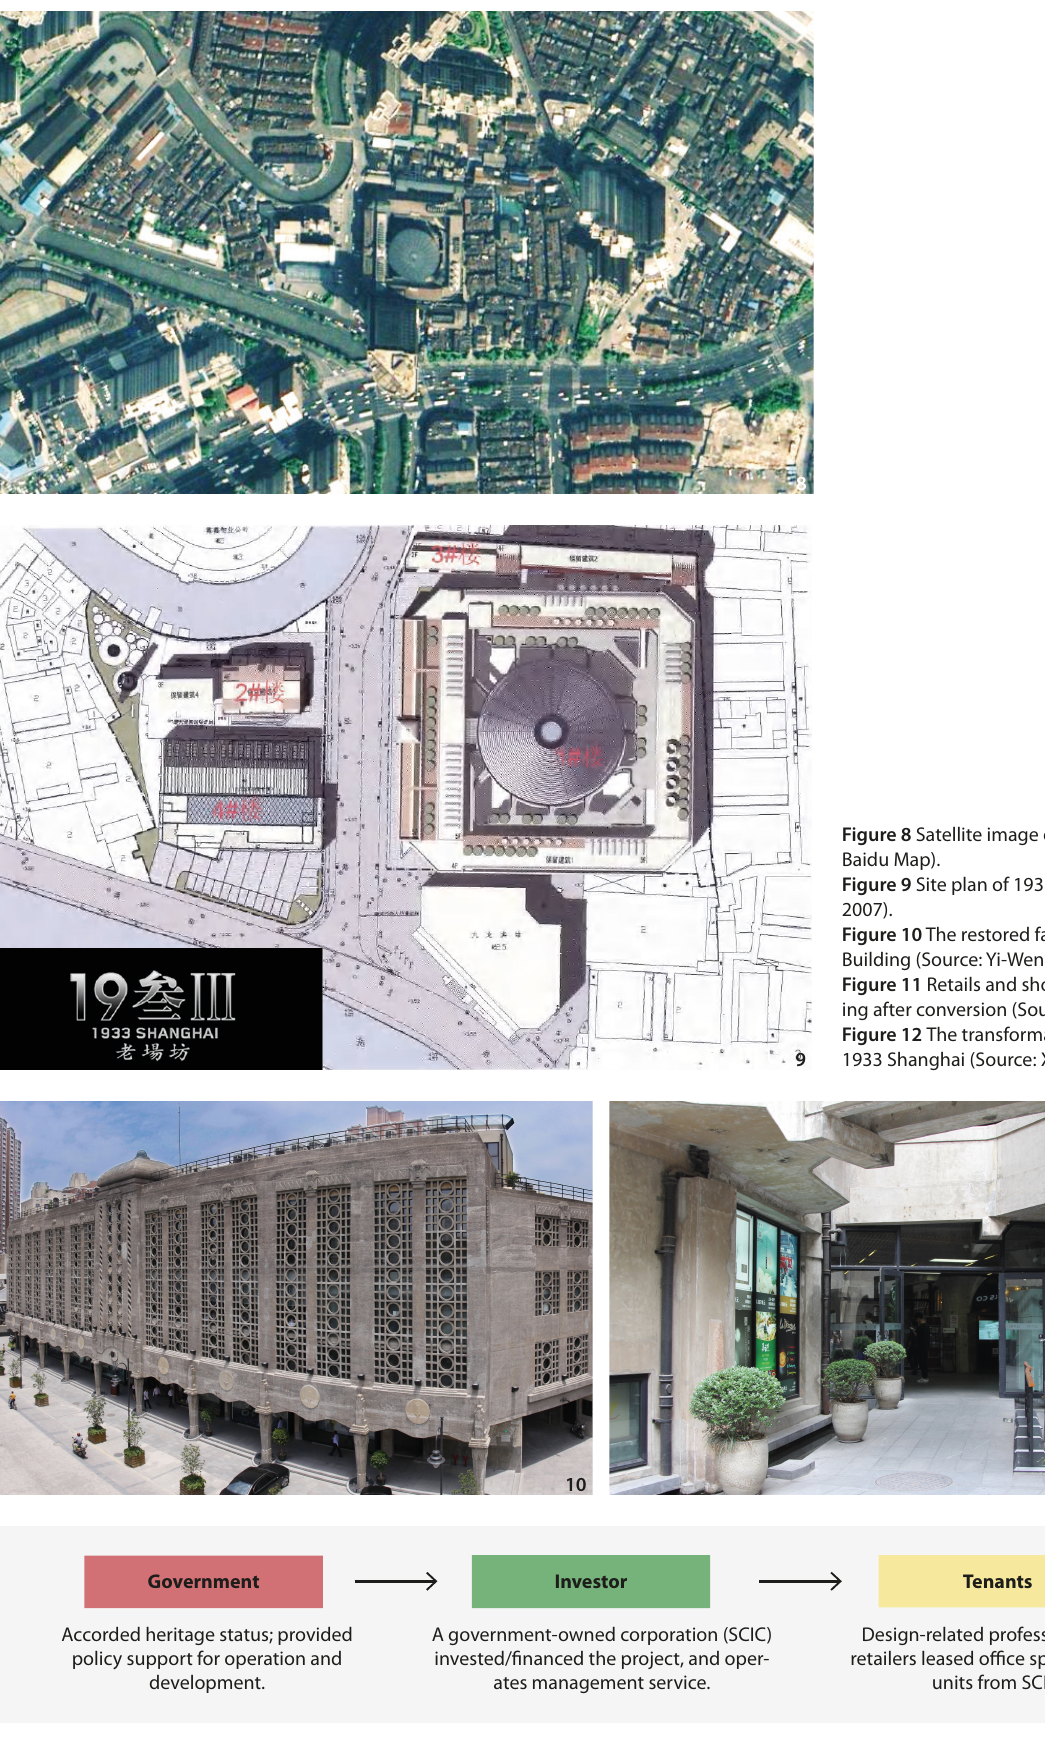
Figure 8 Satellite image of 1933 (Source: Baidu Map). Figure 9 Site plan of 1933 (Source: Zhao 2007). Figure 10 The restored façade of 1933 Building (Source: Yi-Wen Wang). Figure 11 Retails and shops in 1933 Build- ing after conversion (Source: Yi-Wen Wang). Figure 12 The transformation process of 1933 Shanghai (Source: Xiangyi Wang).